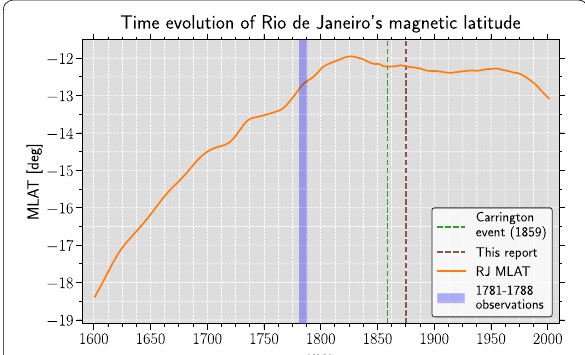
Fig. 2 Time evolution of Rio de Janeiro’s magnetic latitude computed with the geomagnetic field model GUFM1 (Jackson et al. 2000). The light purple bar shows the period corresponding to Sanches Dorta’s magnetic and aurora observations in Rio de Janeiro during the period 1781–1788 (Vaquero and Trigo 2005, 2006). The green and brown vertical lines mark the Carrington event (e.g., Green and Boardsen 2006; Hayakawa et al. 2018b, 2019b) and the eventual sporadic aurora observation here reported